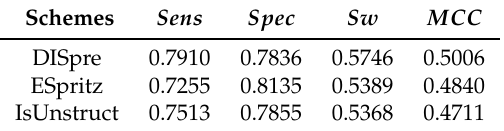
Table 8. Performance comparison with existing schemes on the test set from DisProt.